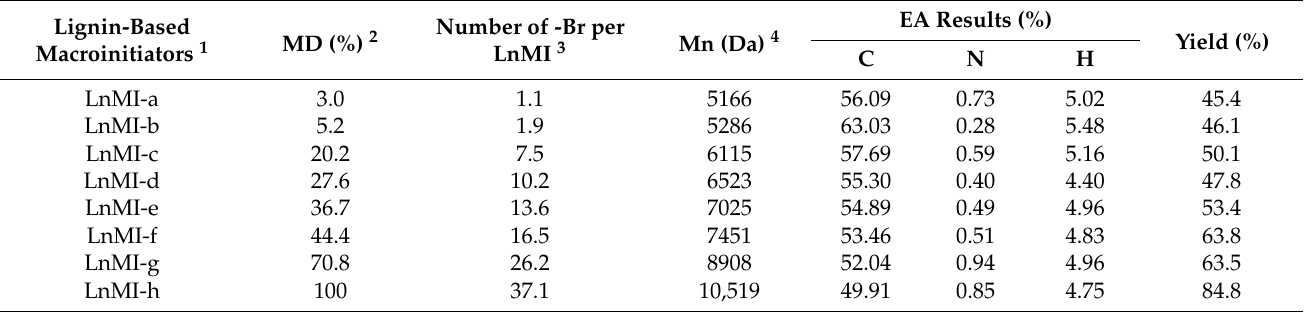
Table 2. The selected characterization results for lignin-based macroinitiators (LnMIs) with different modification degrees.